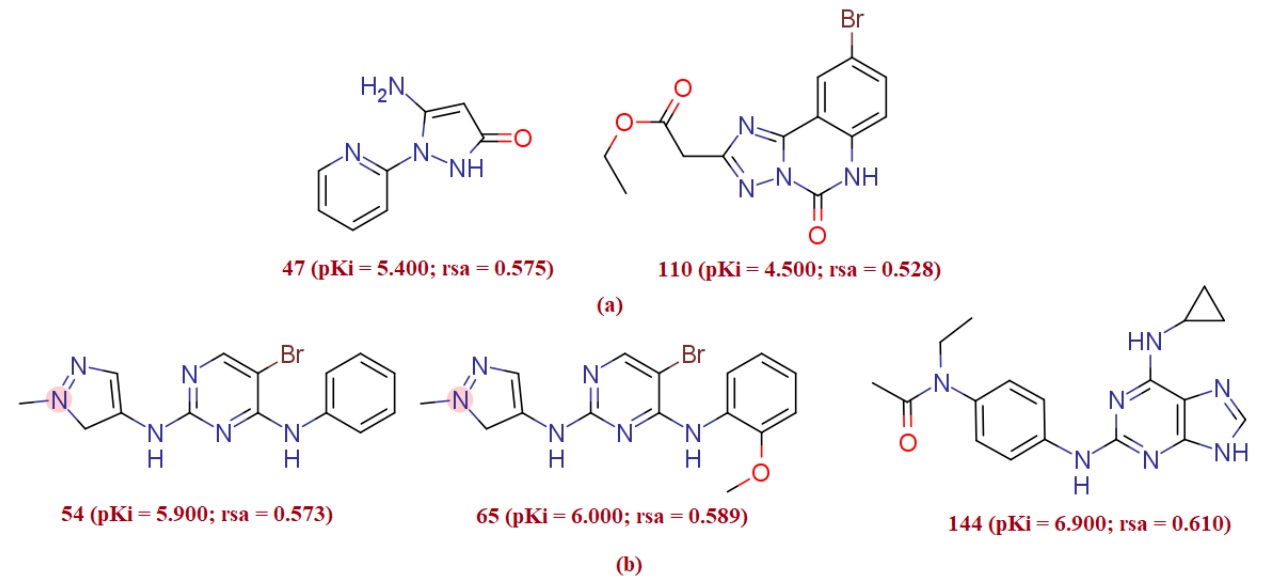
Figure 3. Illustration of the molecular descriptor rsa for the molecular pair 47 and 110 ( a ), and for the molecular pair; 54, 65 and 144 ( b ) only.